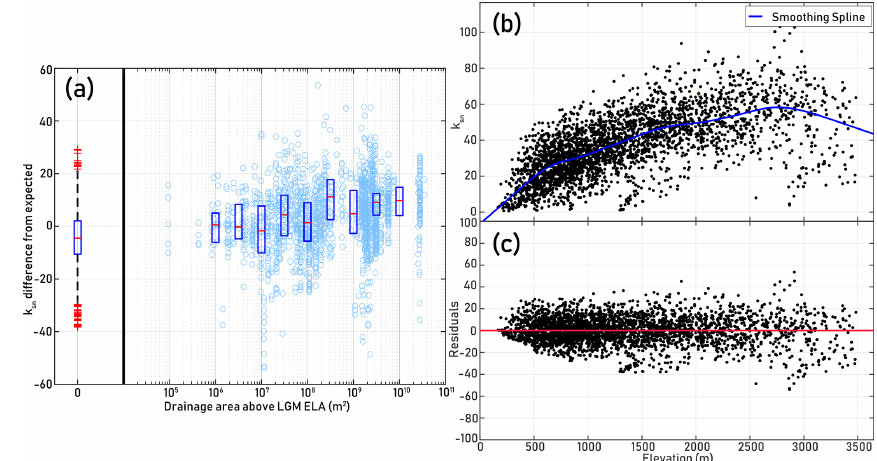
Figure 3. (a) Difference between tributary basin average k sn and expected k sn given basin elevation (based on residuals for spline fit shown in Fig. 3b–c) versus total drainage area above LGM ELA in trunk stream basin ( n = 3047). Box-and-whisker plot to the left of the break shows distribution of k sn differences for tributaries draining to rivers with no drainage area above 4200m. Box shows mean and upper and lower quartiles; whiskers represent 5th and 95th percentiles. Box plots to the right of the break show the mean and upper and lower quartiles for bins centered at boxes. Spearman’s rank correlation coefficient (Spearman’s ρ ), which tests for a potentially nonlinear monotonic relationship, is ρ = 0 . 3899 with P < 0 . 0001 indicating a statistically significant positive correlation. We conducted a two-sample Kolmogorov–Smirnov test for the distributions of average tributary k sn of basins draining to channels with above-ELA drainage areas between 10 7 –10 9 m 2 ( n = 754) and 10 9 –10 10 m 2 ( n = 748) to determine if the samples come from significantly different distributions and found that the empirical CDF (cumulative distribution function) for the first group is larger with P < 0 . 0001, indicating ksn differences are systematically higher for basins draining to rivers with 10 9 –10 10 m 2 of drainage area above 4200m. (b) Smoothing spline fit for tributary basin average k sn vs. basin average elevation, calculated using the “cftool” utility from the MATLAB Curve Fitting Toolbox. (c) Residuals for smoothing spline